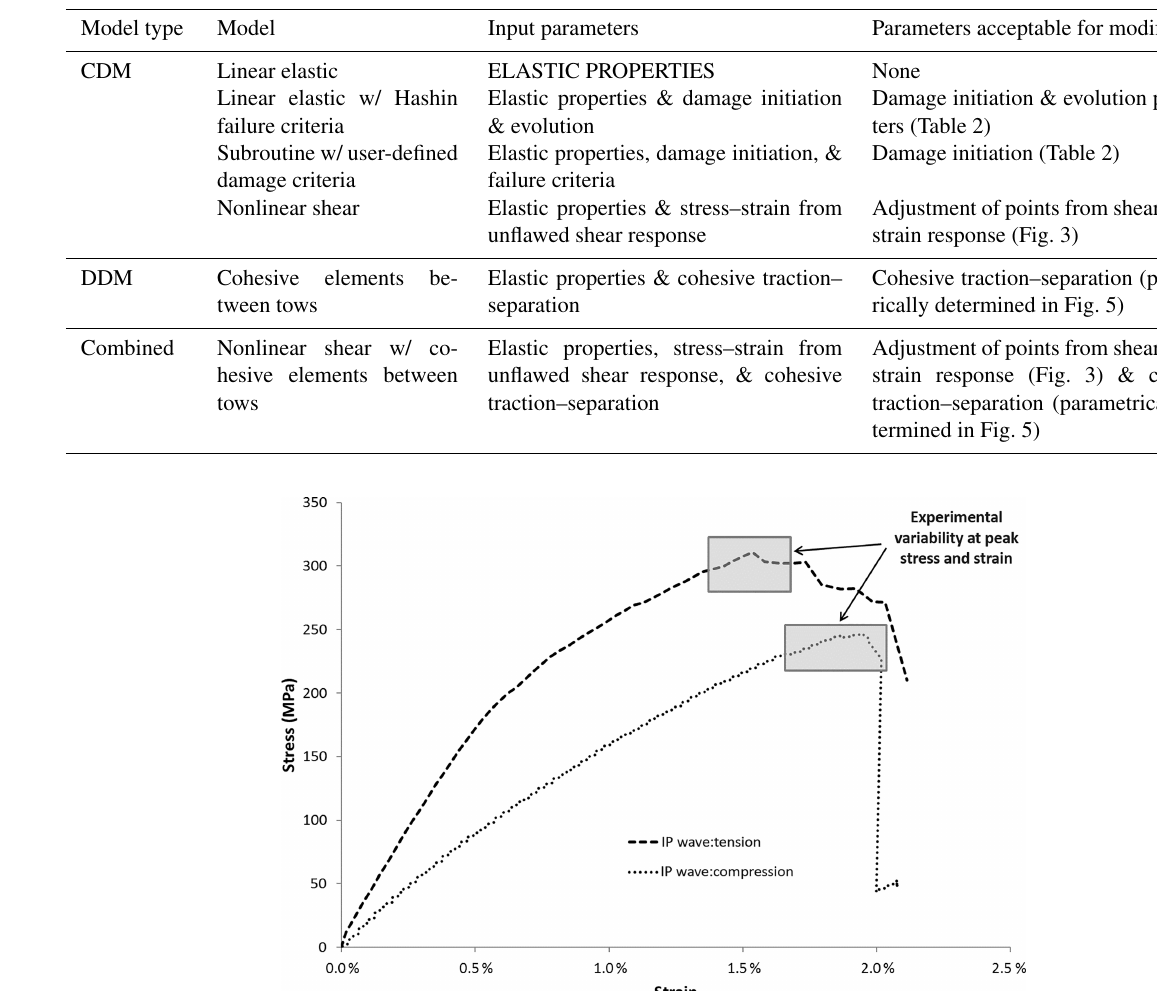
Table 4. Input parameters and acceptable parameters for modification with range of acceptable modification.